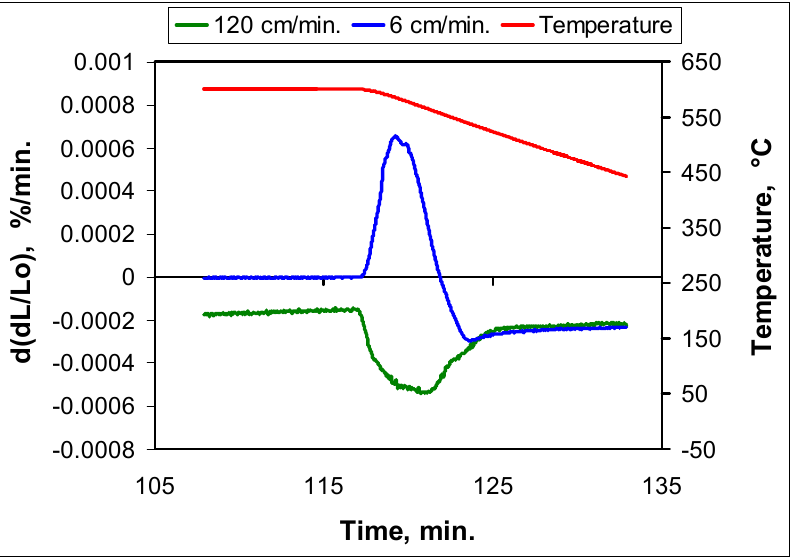
Figure 7. Detailed (from Figure 5) dimensional change rate curves related to the beginning of the cooling stage after the isothermal sintering step for different nitrogen linear flows.